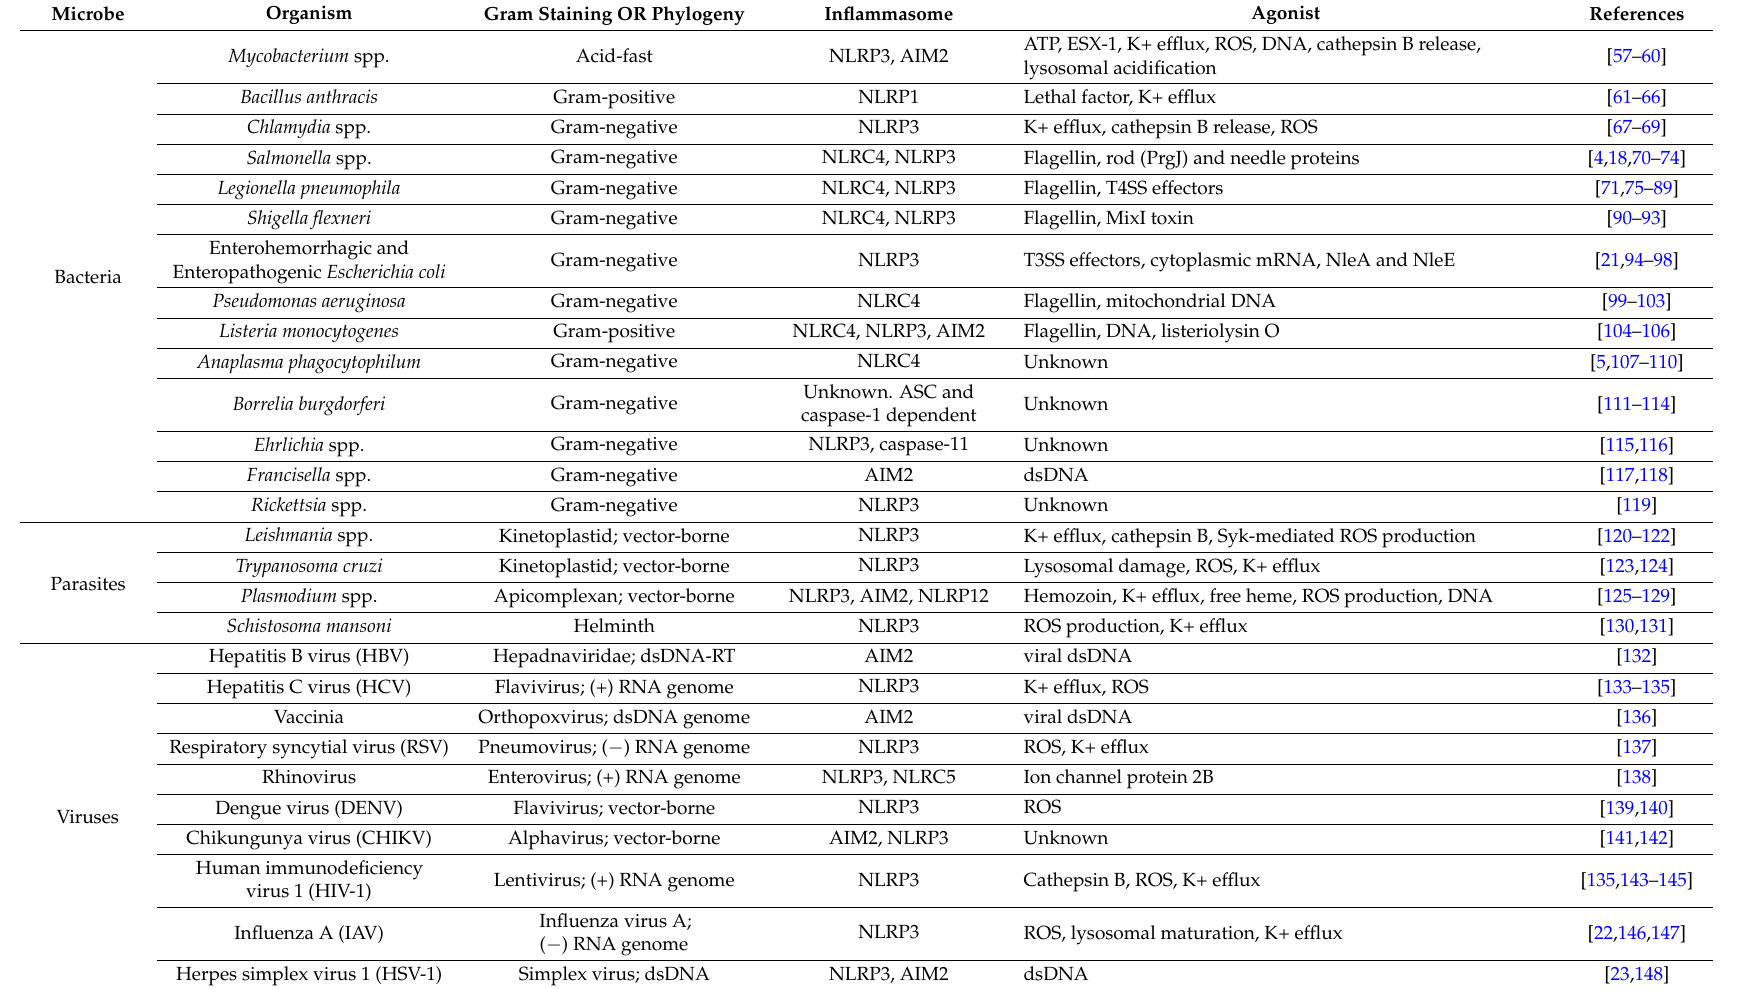
Table 1. Pathogens and associated agonists that elicit inflammasome